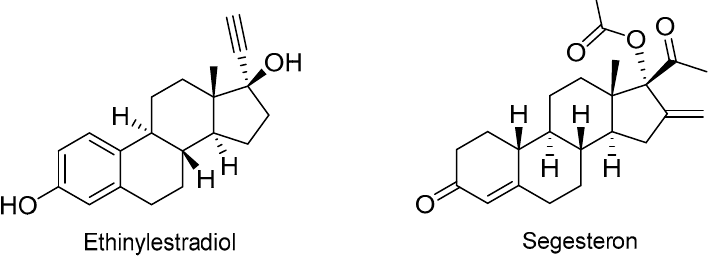
Figure 6. Structure of drugs containing a macrocycle.